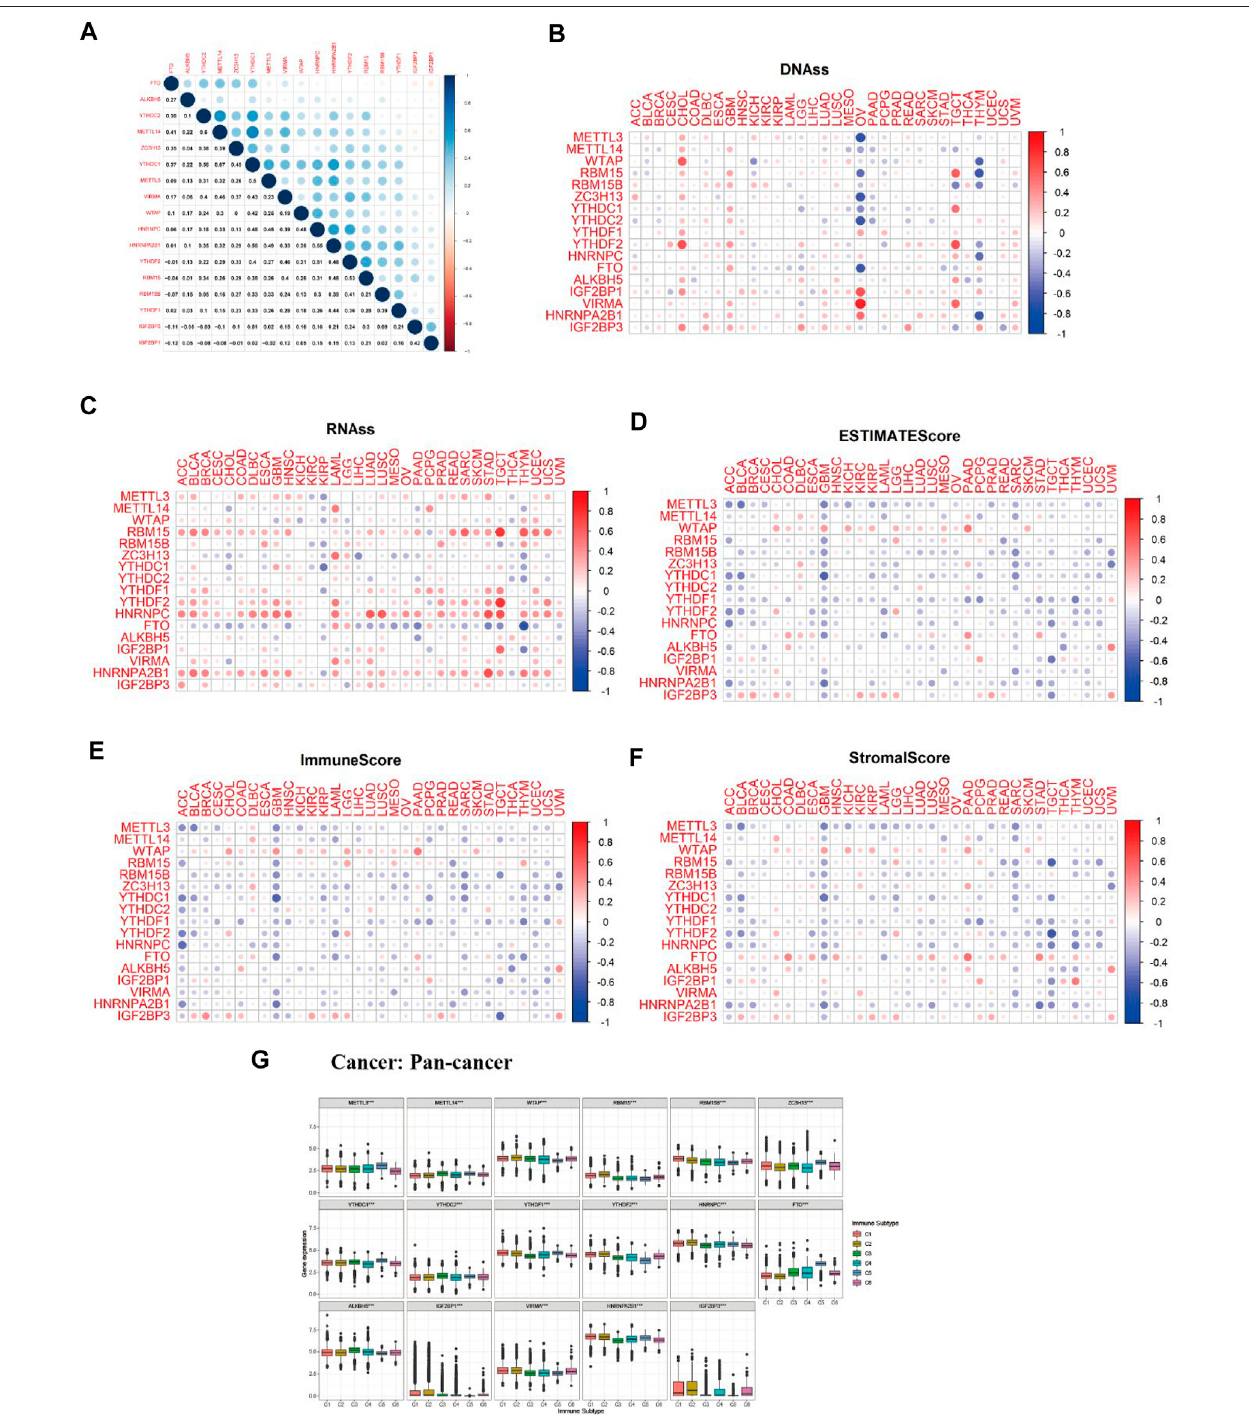
FIGURE 6 | Correlation analysis between m6A-related regulators expression and pan-cancer immune microenvironment and pan-cancer microenvironment. (A) The blue and red dots indicate that m6A methylation regulators expression level had a negative and positive relationship,respectively. (B) The forest map of hazard ratio of 17m6A-related genes across33TCGA cancer types. (C,D) The correlation relationship between 17m6A regulators expression and tumor stem cell score (based on RNA expression and DNA methylation). (E – G) The correlation relationship among the expression of 17 m6A methylation regulators and estimate score, immune score, and stromal score. (H) The boxplot of m6A regulators differential expression in six pan-cancer immune subtypes.